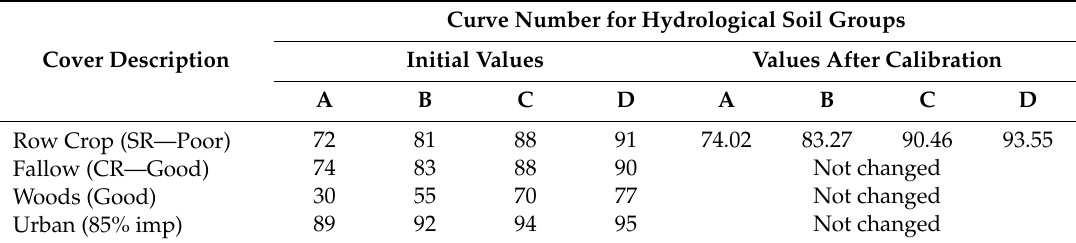
Table 1. Curve numbers (CN) used for model calibration, Sugar Creek watershed. Curve Number for Hydrological Soil Groups Cover Description Initial Values Values After